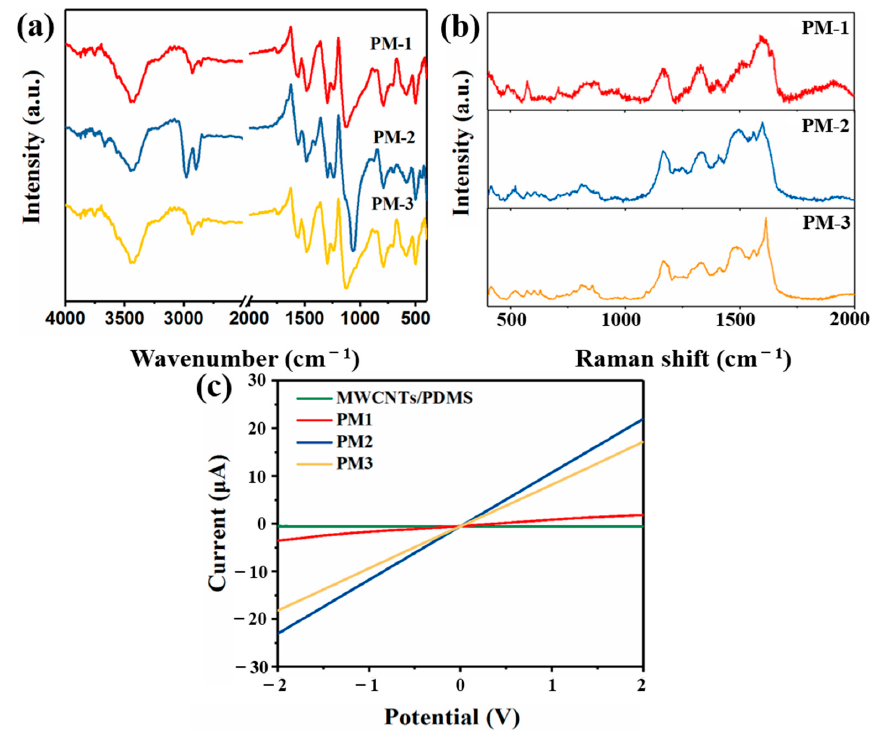
Figure 3. FTIR ( a ), Raman ( b ) and I-V curve ( c ) spectrograms of PANI-MWCNTs/PDMS films.